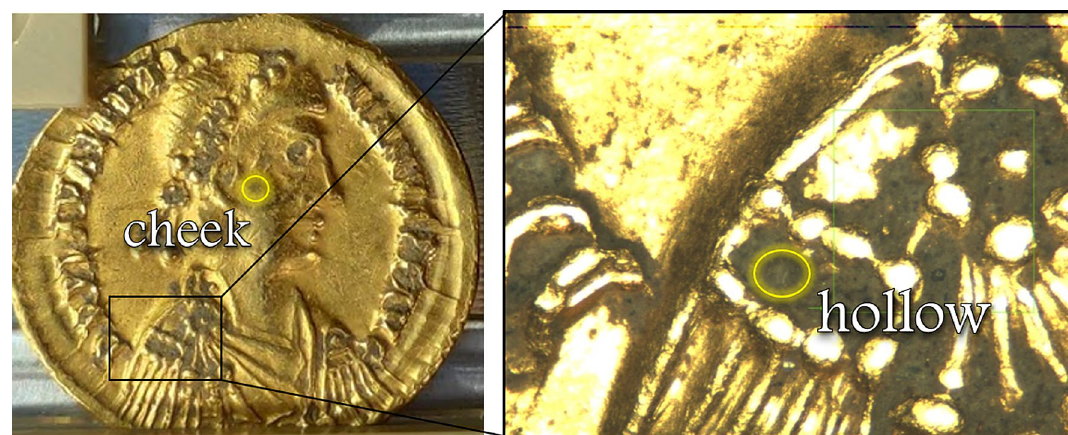
Figure 4. Image of coin D and magnified area showing the two positions where the XANES measurements were carried out.